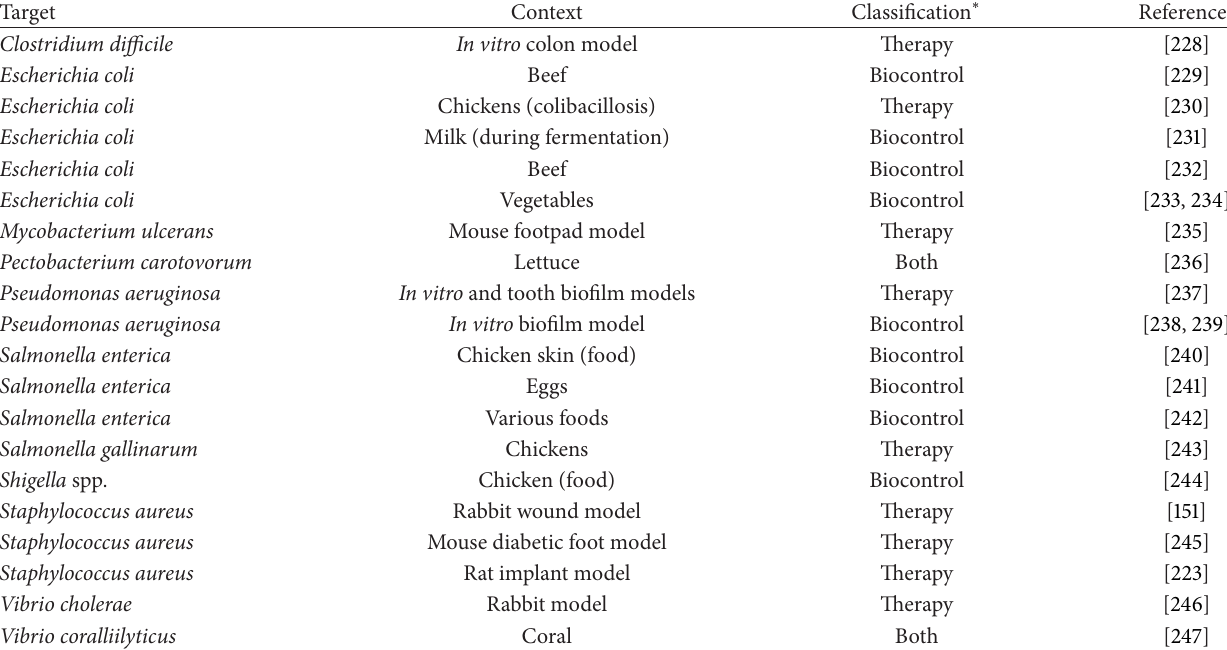
Table 1: Studies involving phage-mediated biocontrol and therapy of bacteria from approximately the first six months of